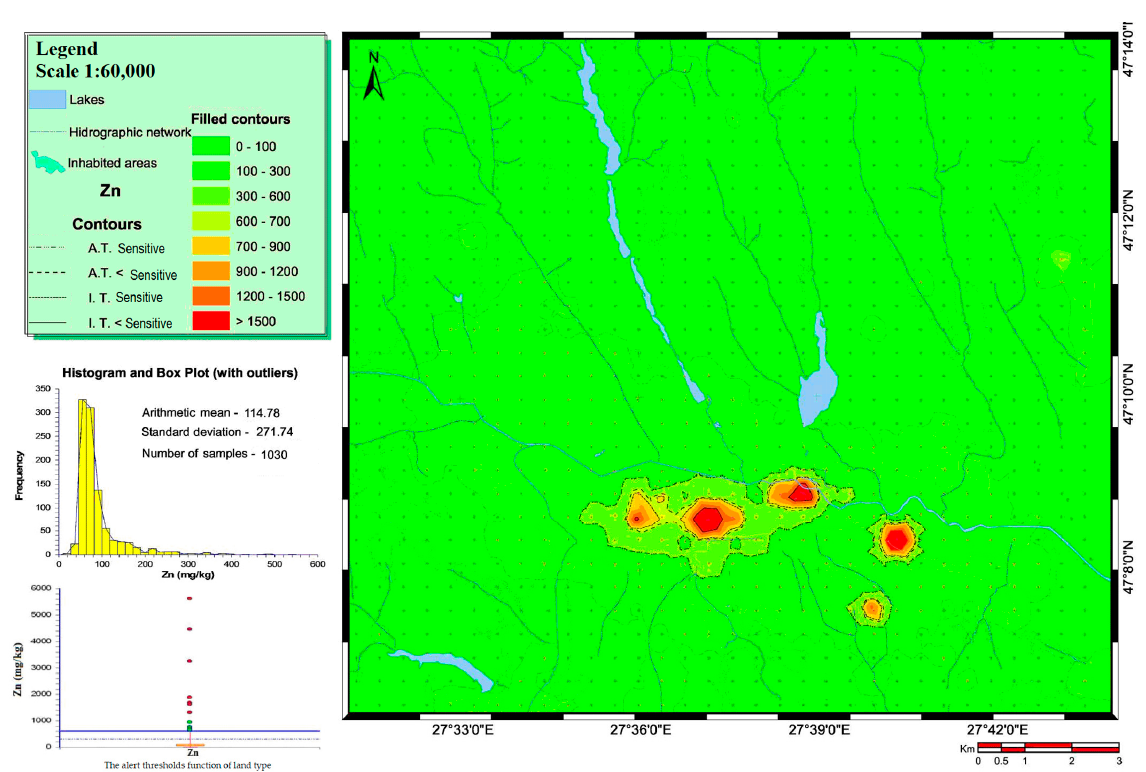
Figure 6. Map of Zn distribution in the analysed soil (mg kg − 1 ).